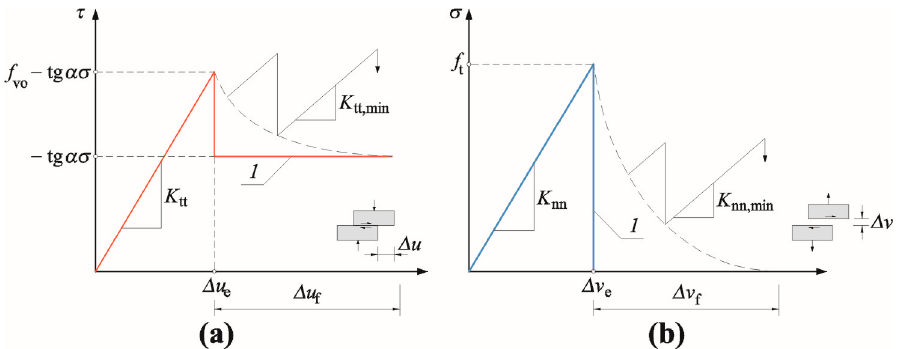
Figure 12. The relationship of shear stress and normal stress with displacement of contact elements ( a ) at shearing, ( b ) under tension; 1 —default function of softening.